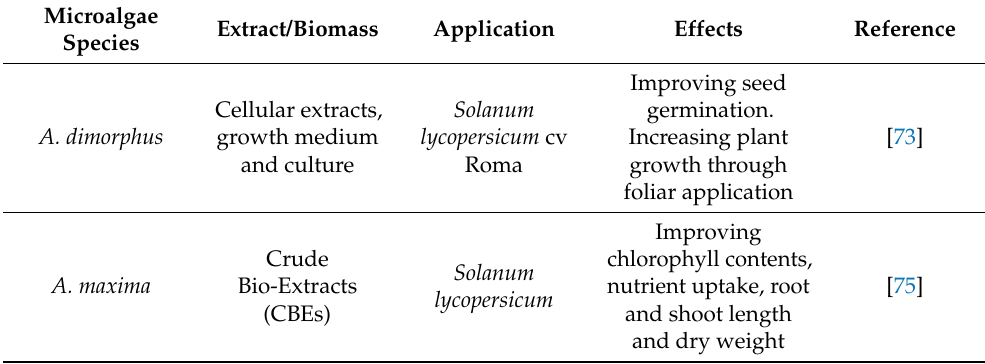
Table 3. Biostimulant effects of different microalgae